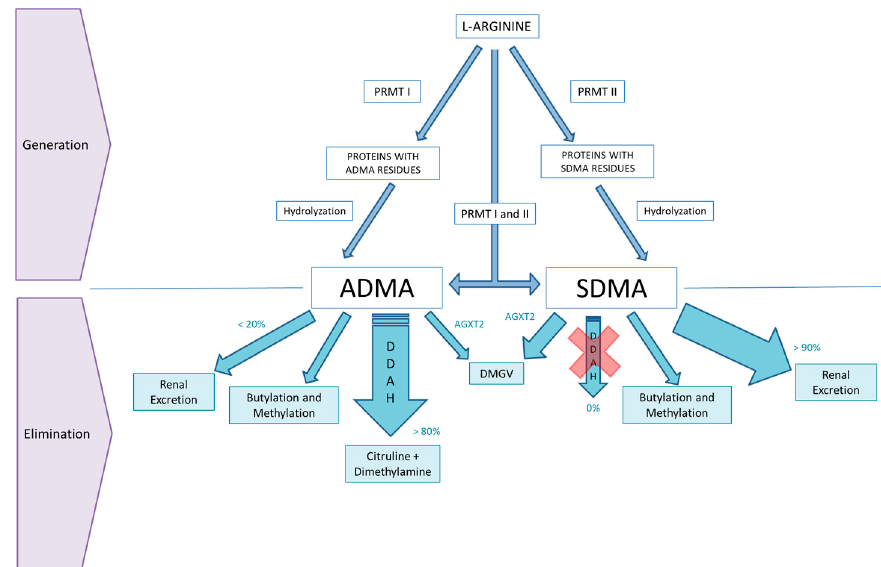
Figure 1. ADMA and SDMA metabolism. Both asymmetric dimethylarginine (ADMA) and